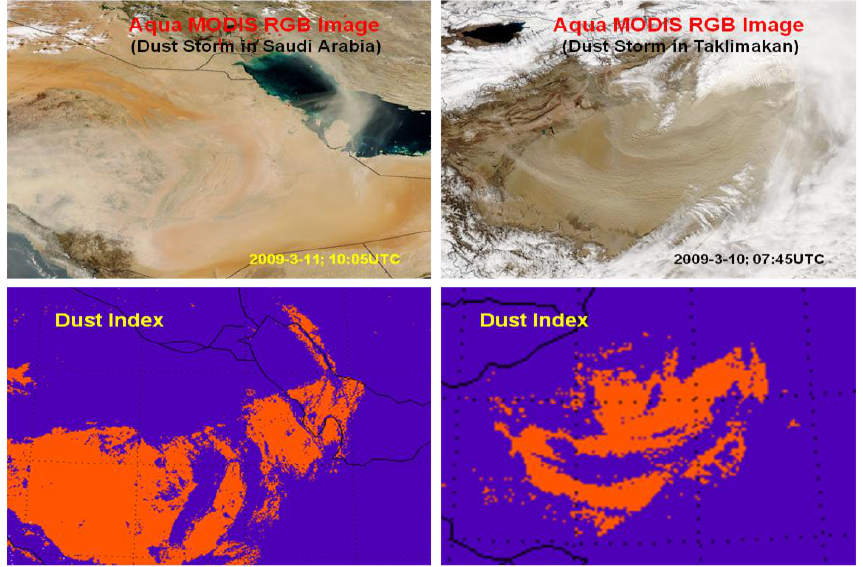
Figure 14. Top: red-green-blue (RGB) false color images of an Aqua MODIS observation of dust storm in Saudi Arabia (left) and in Taklimakan desert (right). Bottom: the results of the dust detection where pixels flagged as dusty are red.